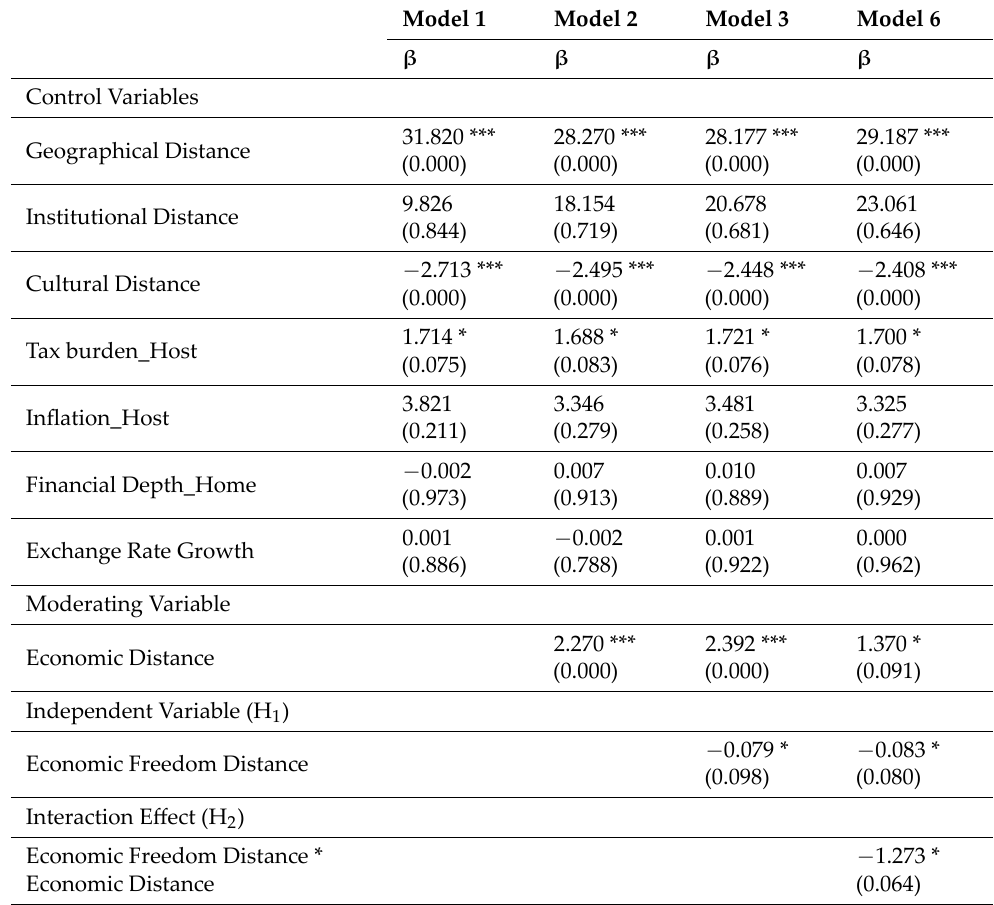
Table 5. Tobit regression models presenting the impact of independent variables on India’s inbound CBA volume and the control